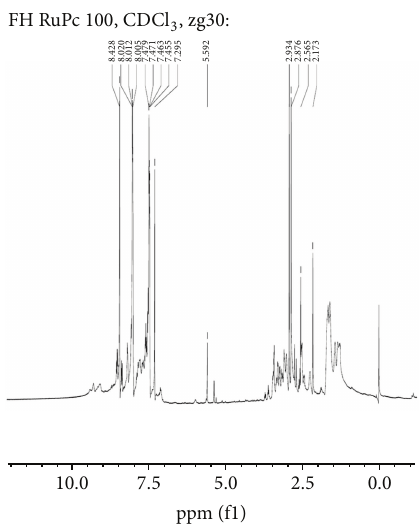
Figure 1: UV-Vis absorption spectra of ( C 1 R 󸀠 RuPc ), ( C 2 R 󸀠󸀠 RuPc ), and ( C 3 R 󸀠󸀠 RuPc ) in DMF solution.